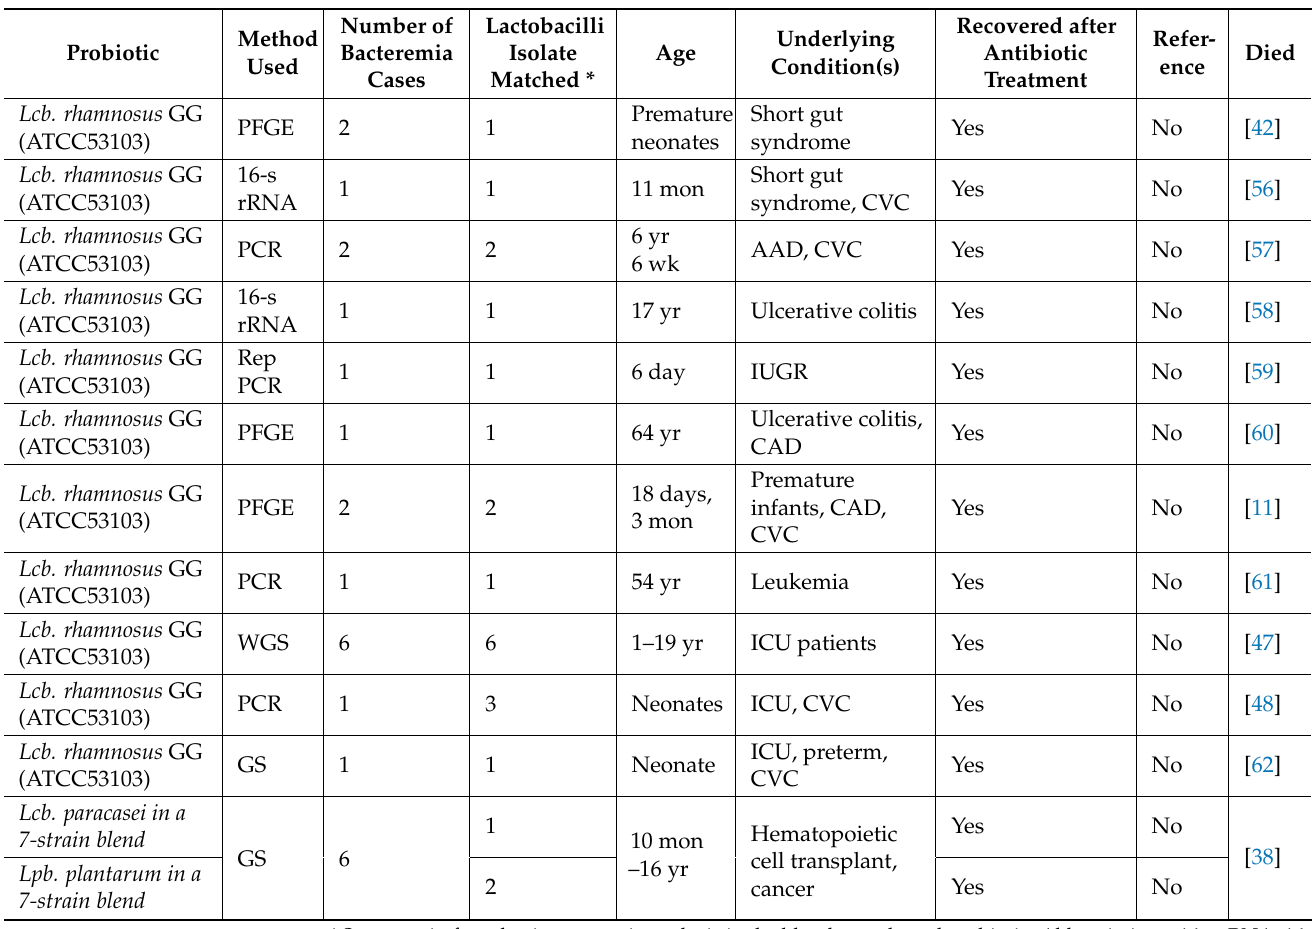
Table 3. Cases of Lactobacilli bacteremia confirmed to be associated with the same strain of oral Lactobacilli probiotic